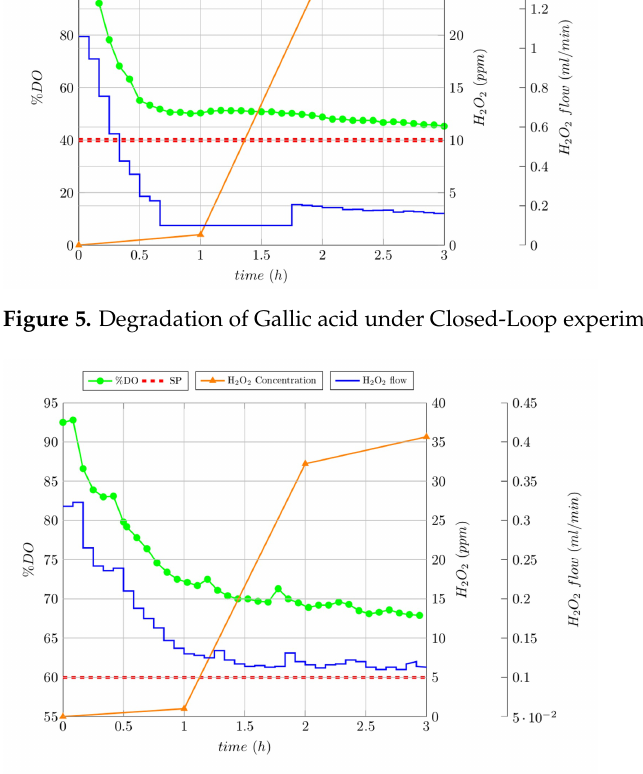
Figure 6. Degradation of lignin under Closed-Loop experimental conditions.